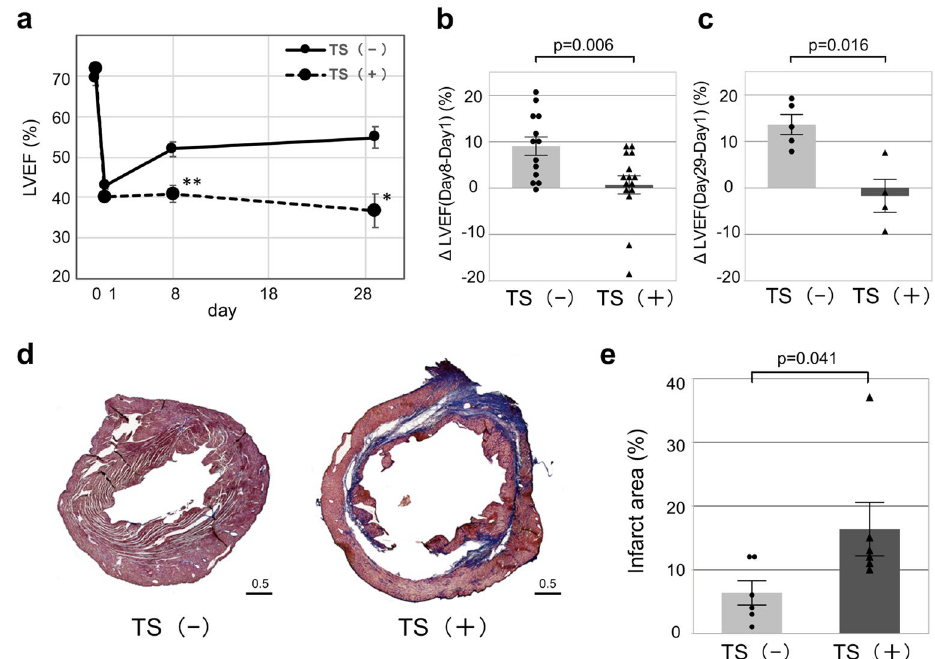
Figure 2. Experimental sarcopenia impairs cardiac after I/R. ( a ) Absolute changes in the LVEF on days 1, 8 in TS (+) (n = 15) and TS (−) (n = 13; 2 mouse early death), days 29 in TS (+) (n = 5) and TS (−) (n = 4), ΔLVEF ( b , Day 8–Day 1, c Day 29—Day 1) in the 2 groups of mice. Left bar; TS (−), Right bar; TS (+). *p < 0.05, **p < 0.001 vs. TS (+). ( d ) Representative images of cardiac tissue sections (short axis view; day 28 post-MI) stained with Masson’s Trichrome. The fibrotic areas are stained blue. Left side; TS (−). Right side; TS (+). Scale bar = 0.5 mm. ( e ) Quantitative analysis of the percentage of the fibrotic area as a function of the total LV area (n = 6 per group). Left bar; TS (−), Right bar; TS